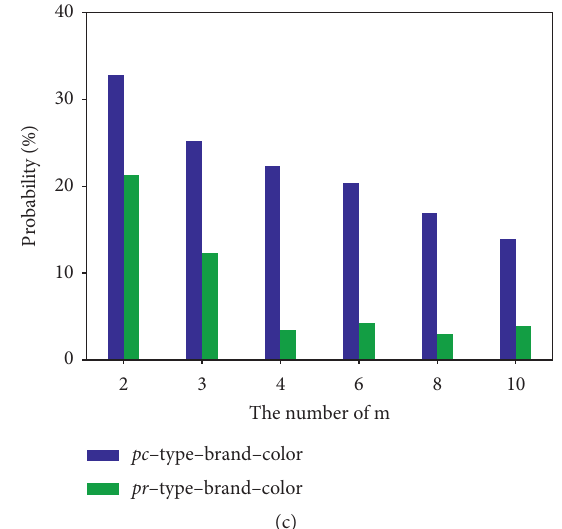
Figure 8: The probabilities pc and pr with different ms and ns . (a) The comparison of pc and pr with one SA. (b) The comparison of pc and pr with two SAs. (c) The comparison of pc and pr with three